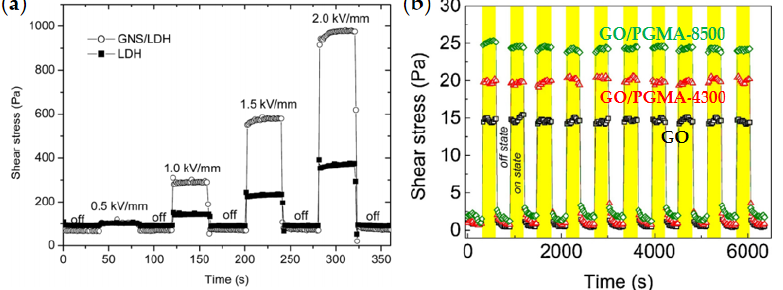
Figure 14. The on/off field response for ER fluids: ( a ) GNS/LDH and LDH [90]; ( b ) GO/PGMA and GO [78]. GO